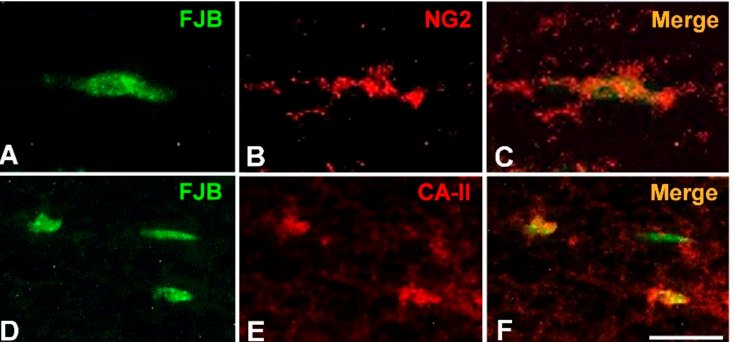
Figure 7. Identification of FJB-positive cells in the white matter of mice exposed to uf-UPs for 4 weeks. Most FJB-positive cells (green) in the white matter are double-labeled with either NG2 (red), an adult OPC marker ( A – C ), or CA-II (red), an mOL marker ( D – F ). Scale bar = 10 µ